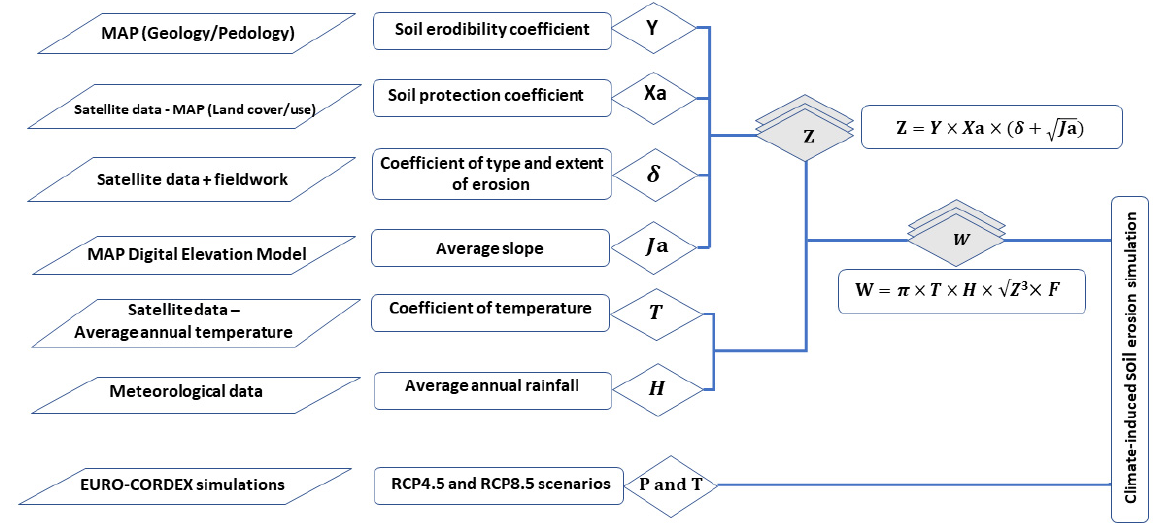
Figure 2. Flowchart of the methodology EPM climate simulation EURO-CORDEX approach.